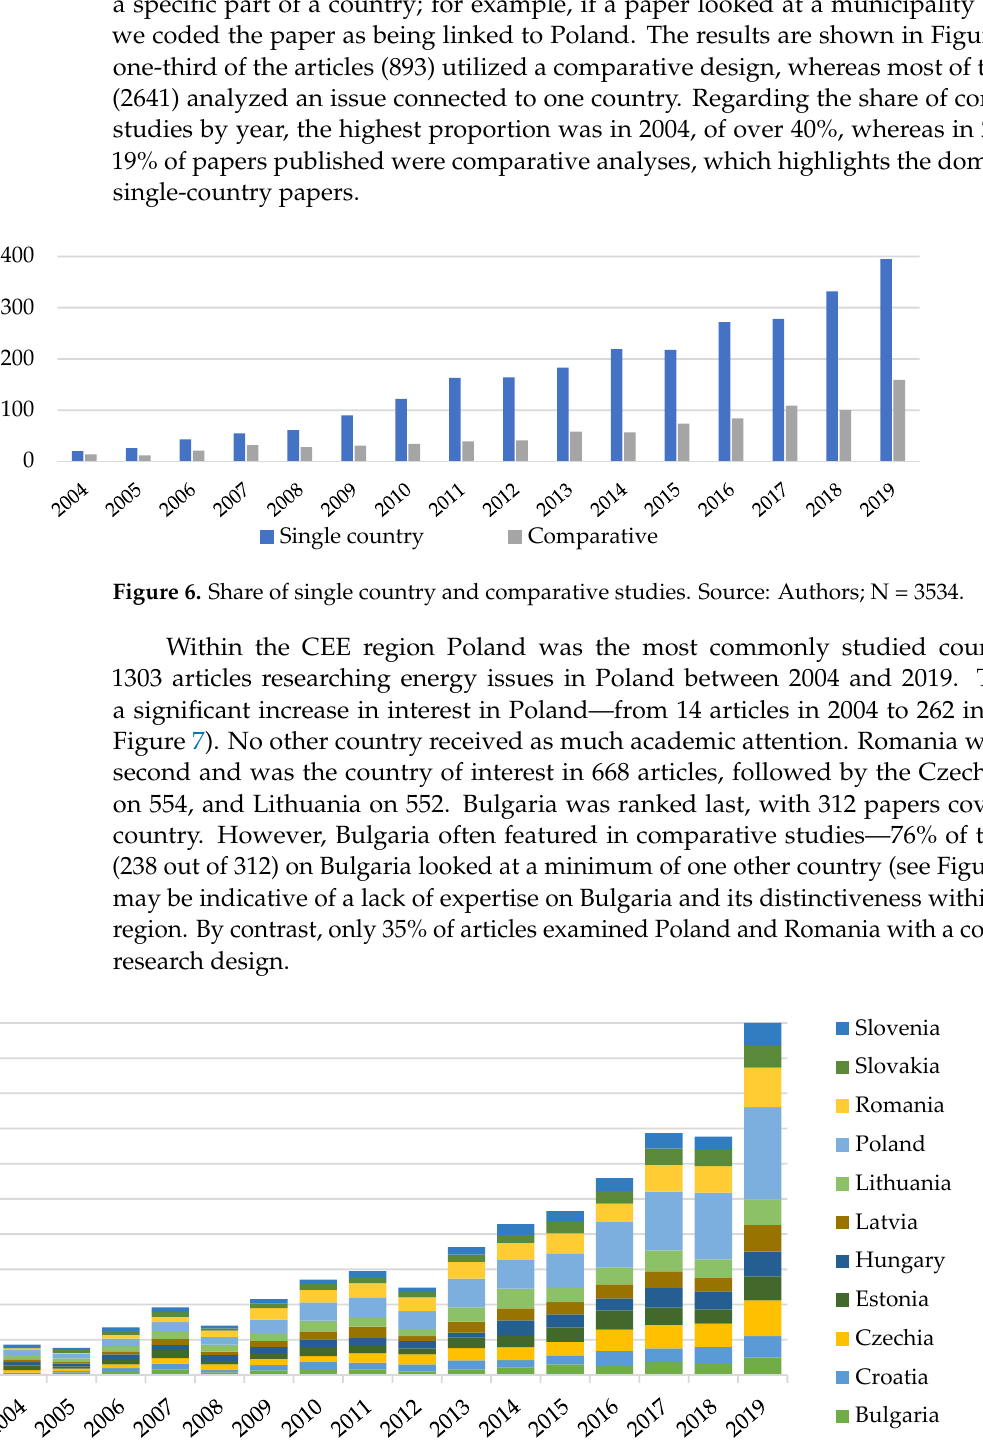
Figure 7. Number of articles covering CEE countries in our dataset. Source: Authors; N = 5838.